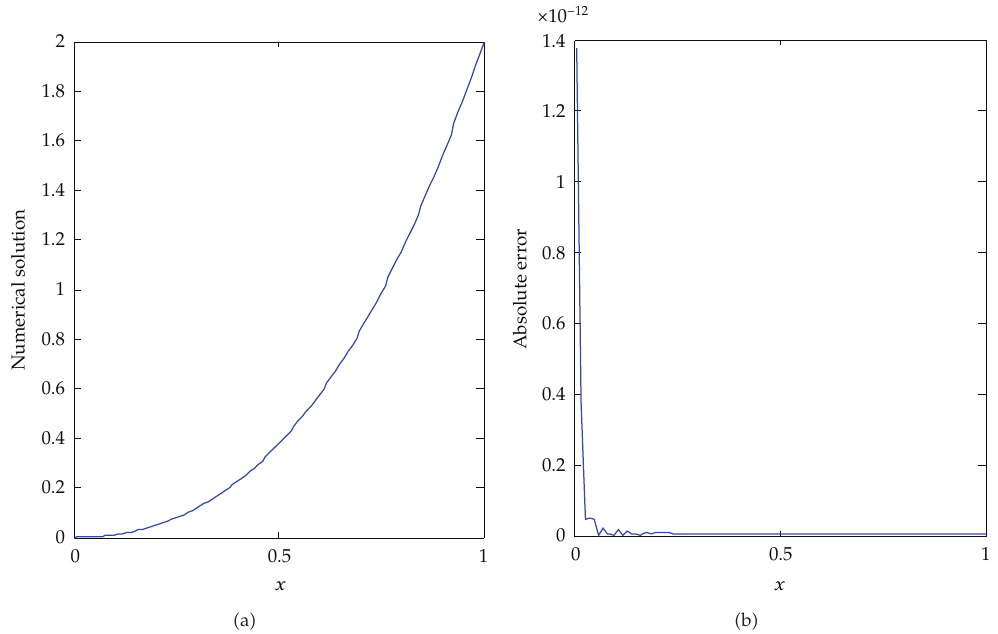
Figure 1: Numerical solution and absolute error of Example